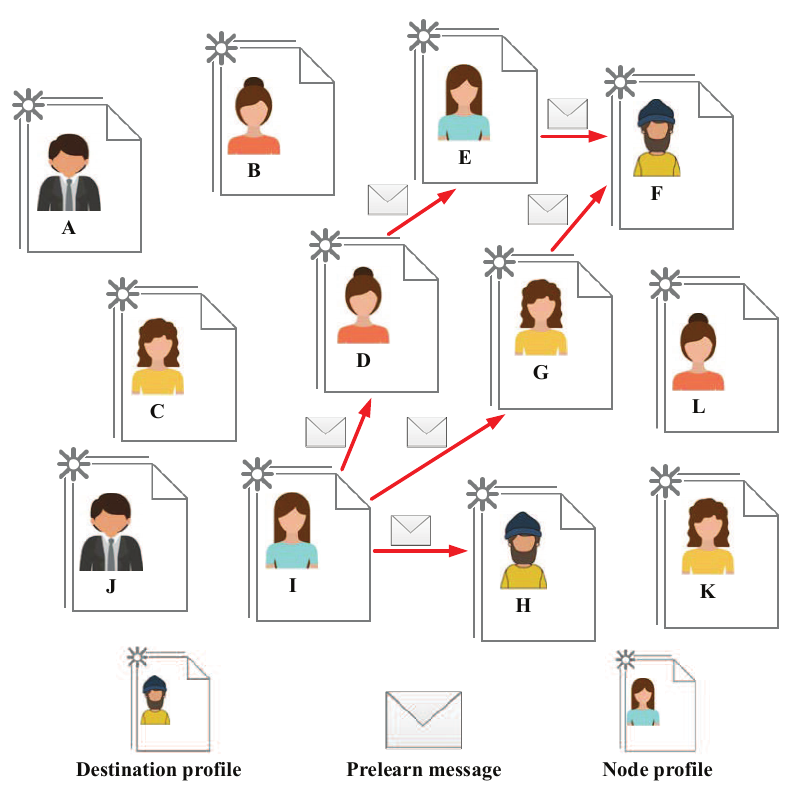
Figure 4. The delivering process diagram of Forward